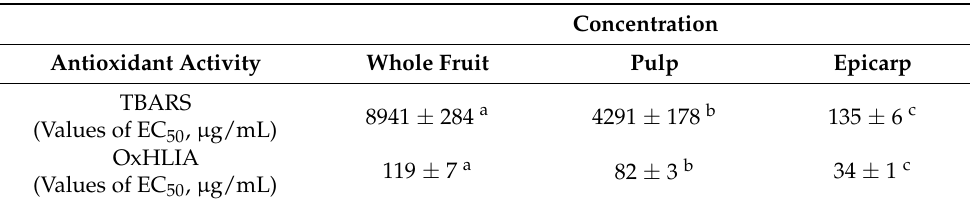
Table 6. Antioxidant activity of the hydroethanolic extracts of the whole fruit, pulp, and epicarp of S. melongena. (mean ± SD).